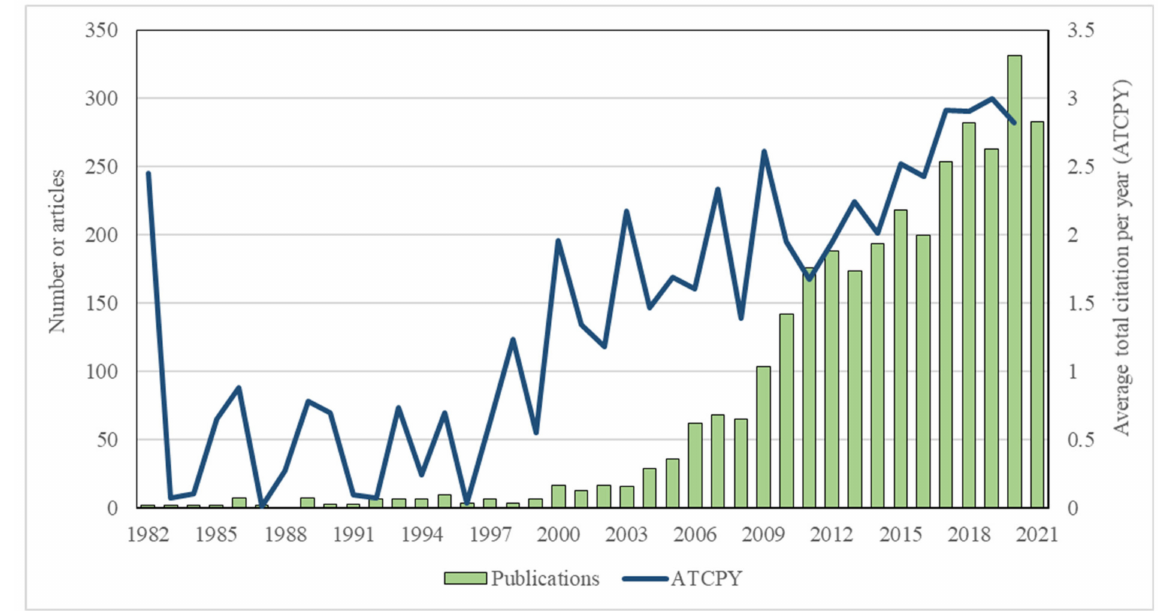
Figure 2. Publishing trend and average citation on